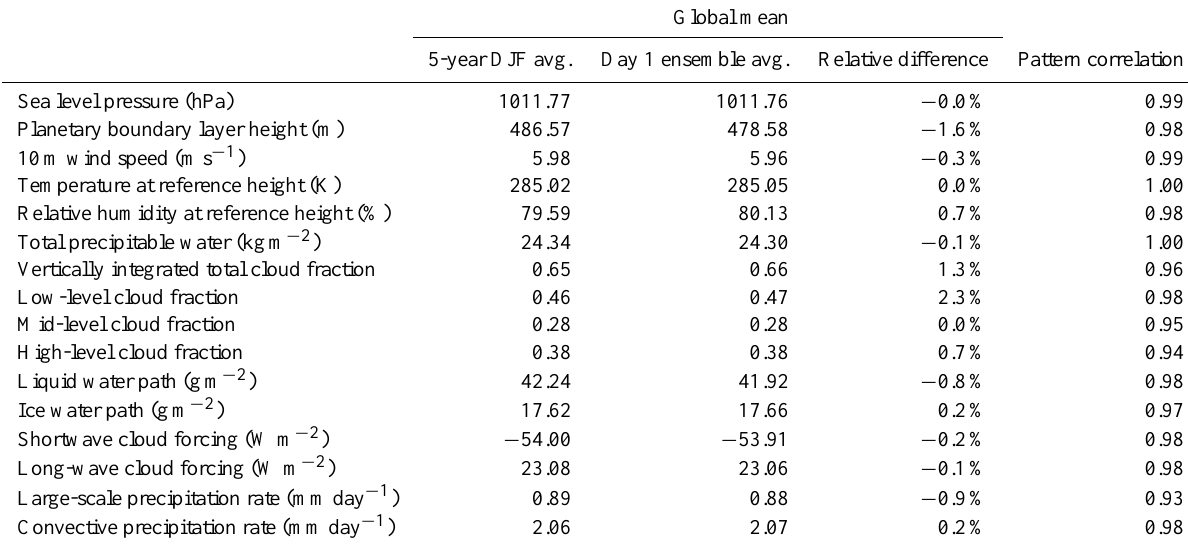
Table 1. Global mean values and pattern correlations of the atmospheric mean state in a multi-year climate integration and an ensemble of short simulations. The 5-year mean climatology of December–January–February (DJF) is compared to the 50-member mean of day 1 average. All simulations were performed with a 30min model time step. Further details are explained in Sect. 3.1.